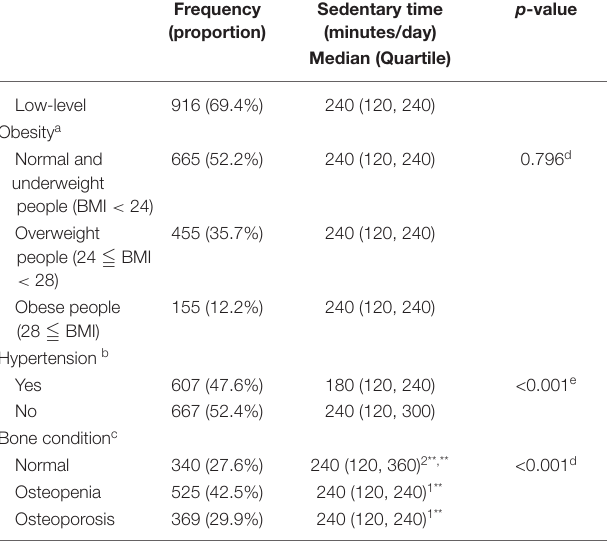
TABLE 1 | Basic conditions of social demography and physique ( n = 1,320), characteristics of daily